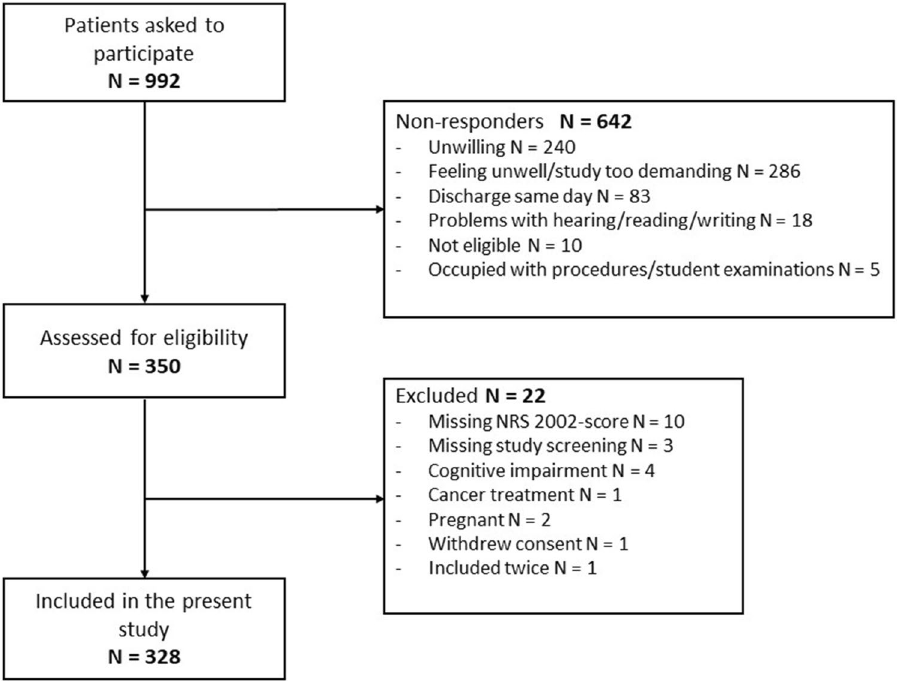
Figure 1. Flow chart of the recruitment and sample